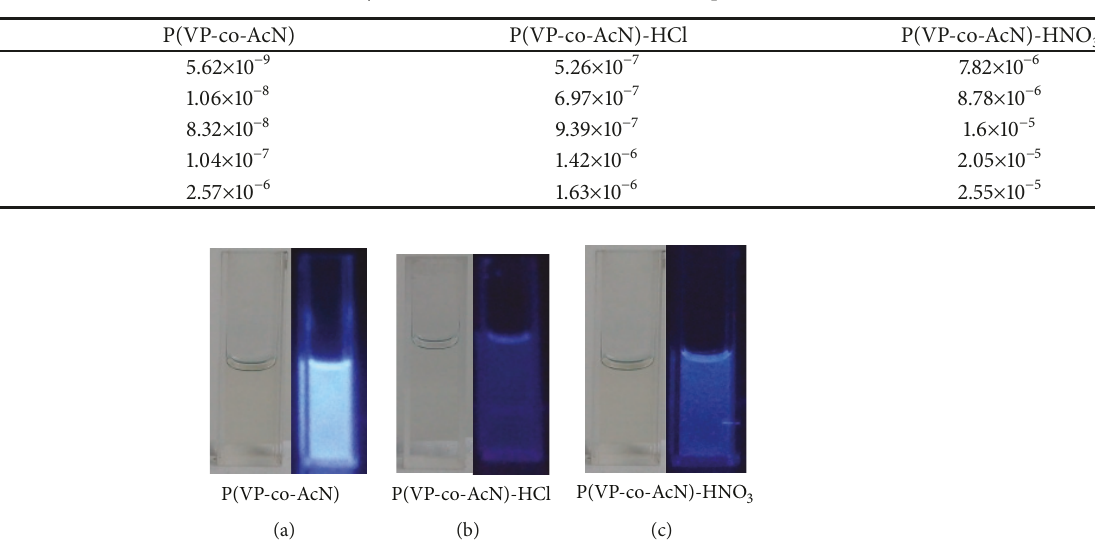
Table 2: Conductivity data at 30 ∘ C obtained at different frequencies.